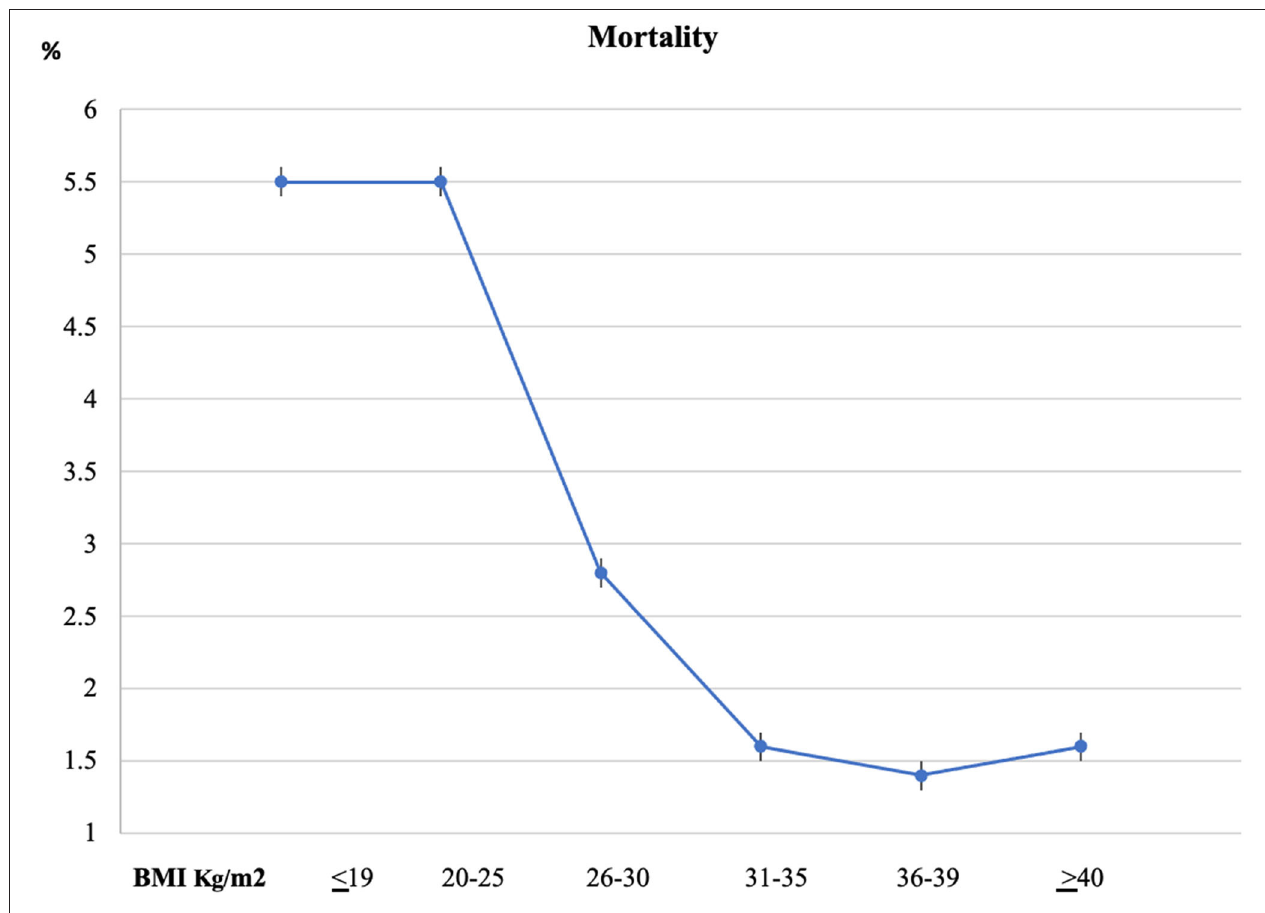
FIGURE 1 | Mortality rate via body mass index (BMI)